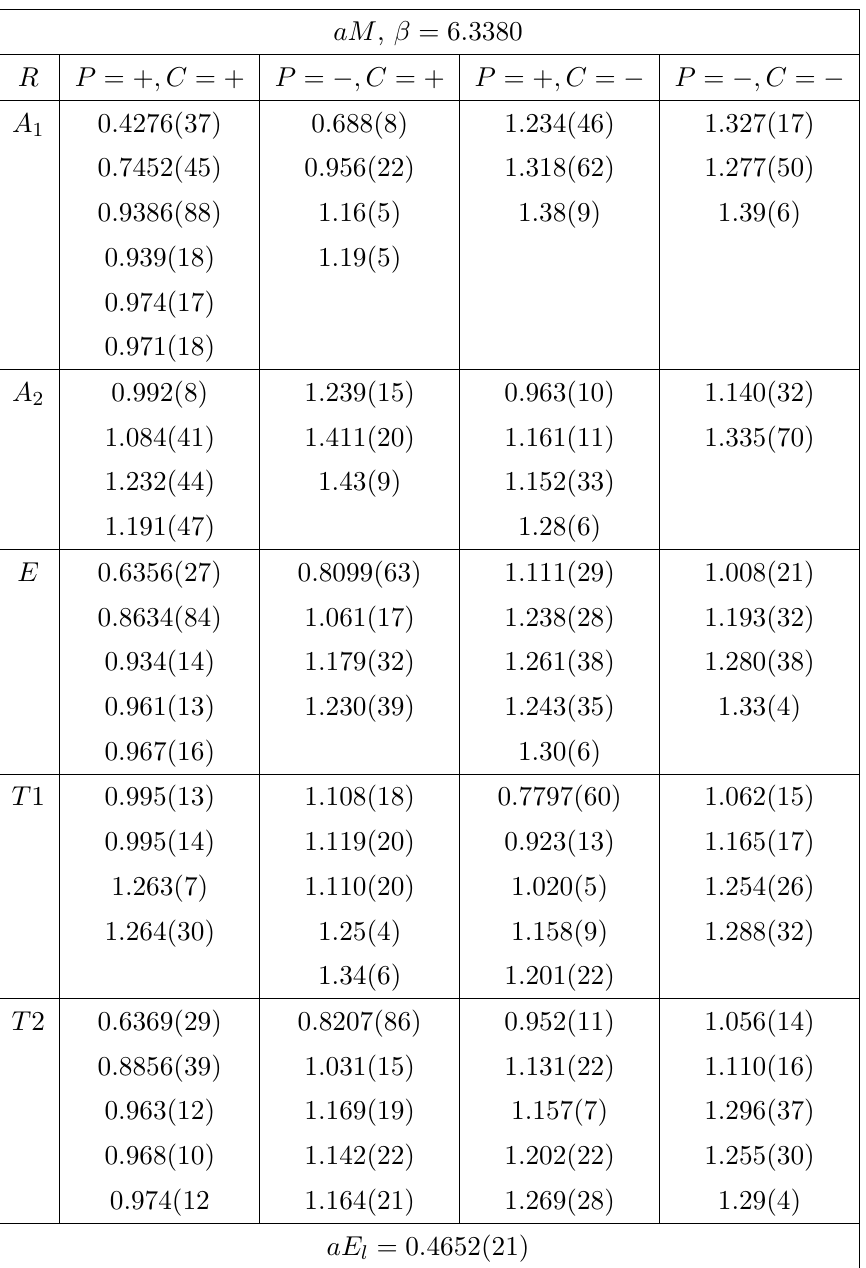
Table 12 . Glueball masses at β = 6 . 3380 on a 30 4 lattice for all octahedral representations, R , and for both values of parity, P , and charge conjugation, C . Also the energy E l of a winding flux